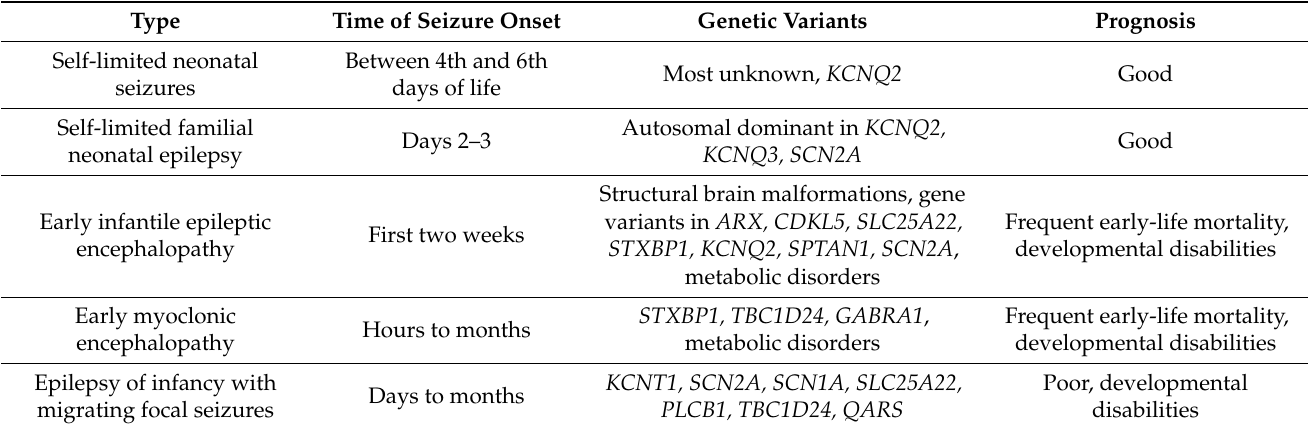
Table 4. Types of single gene mutations in neonatal epilepsy